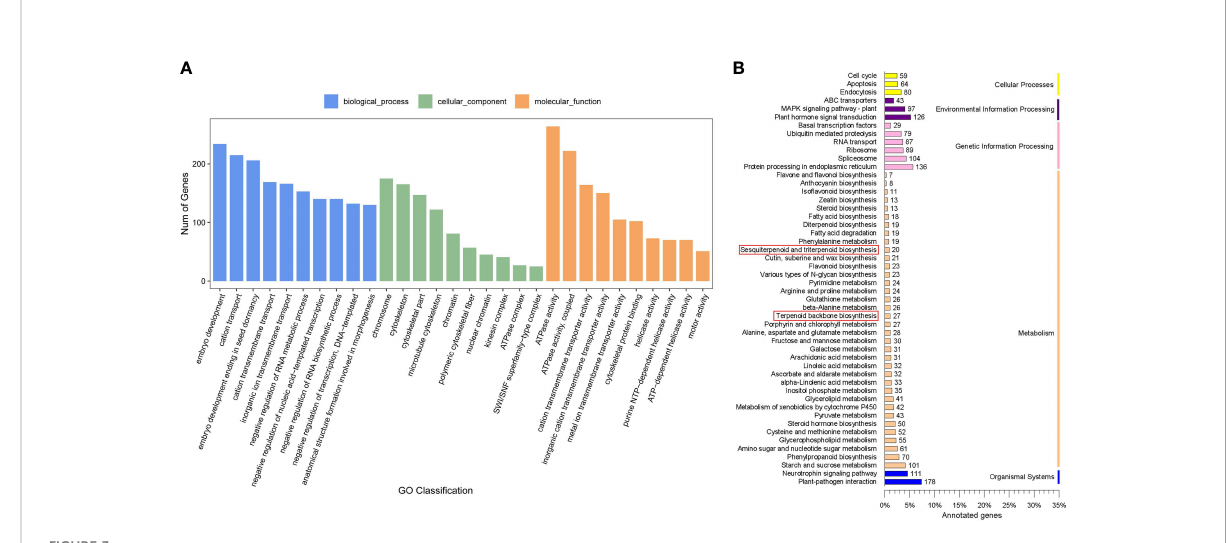
FIGURE 3 Target genes analysis of miRNAs. (A) GO enrichment analysis of target genes. (B) KEGG pathways analysis of target